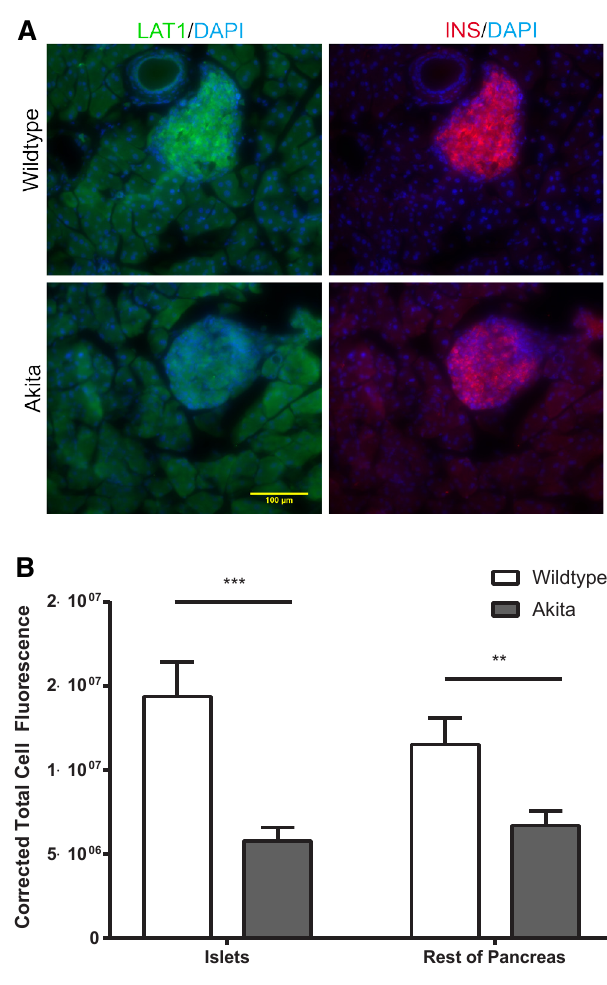
Islets Rest of Figure 3. Immunofluorescence microscopy of LAT1 and insulin in the pancreas of wt and Akita mice. a ) Representative fluorescence images of islets and surrounding tissue shows the distribution of LAT1 (green) and insulin (red). Nuclei are highlighted with DAPI staining (blue). b ) Quantification of total corrected cell fluorescence of LAT1 immunoreactivity in islets and the rest of the pancreas. White bars represent values from wt mice, and grey bars represent values from Akita mice. Values are means ± SEM (n=6). * p<0.05 compared to corresponding wt values.